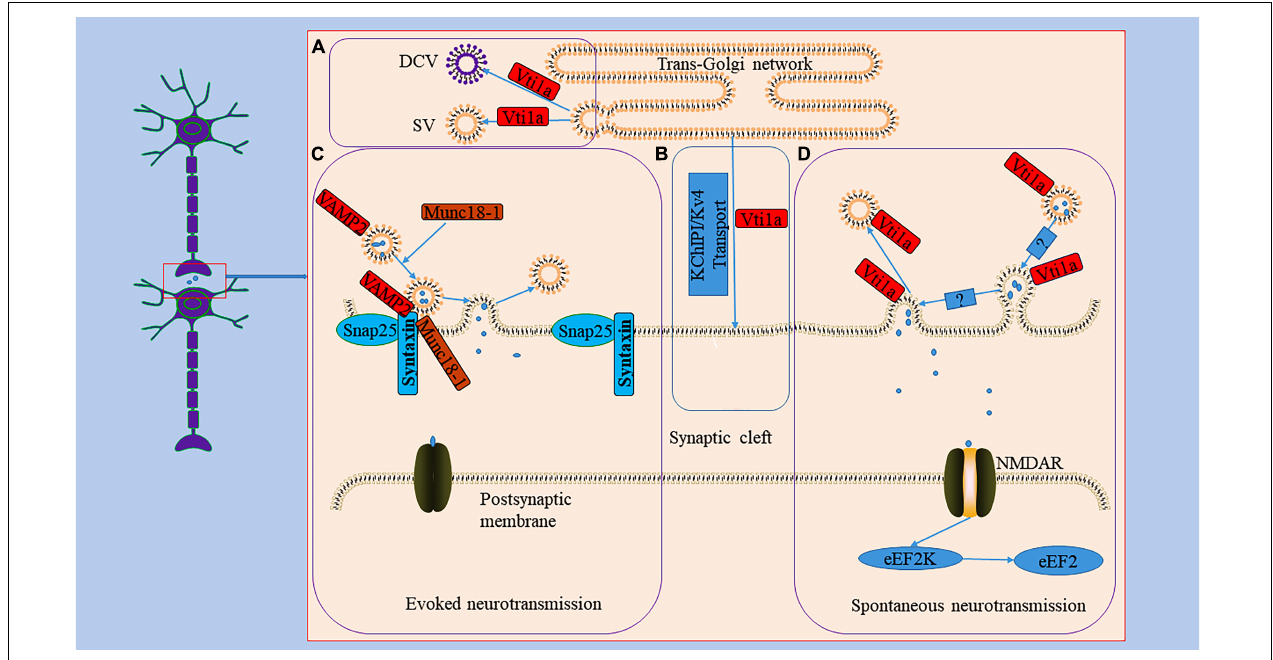
FIGURE 2 | The role Vti1a in spontaneous transmission. Panel (A) , it reveals the generation of DCV and SV in TGN; Vti1a is mainly localized to TGN to regulate the secretion of SV and DCV. Panel (B) , it shows an unconventional exocrine pathway; Vti1a transports KChIP1/Kv4 through an unconventional exocrine pathway. Evoked neurotransmission and spontaneous neurotransmission are the two main ways of synaptic transmission. Panel (C) , it represents the process of the evoked neurotransmission; the synaptic vesicle protein VAMP2 forms a SNARE complex with SNP25 and Syntaxin and mediates vesicle trafficking in evoked neurotransmission under the regulation of Munc18-1. Panel (D) , it displays the process of the spontaneous transmission; Vti1a drives synaptic vesicle activity to mediate spontaneous transmission with an unclear mechanism to activate NMDAR to activate eEF2K to dephosphorylate